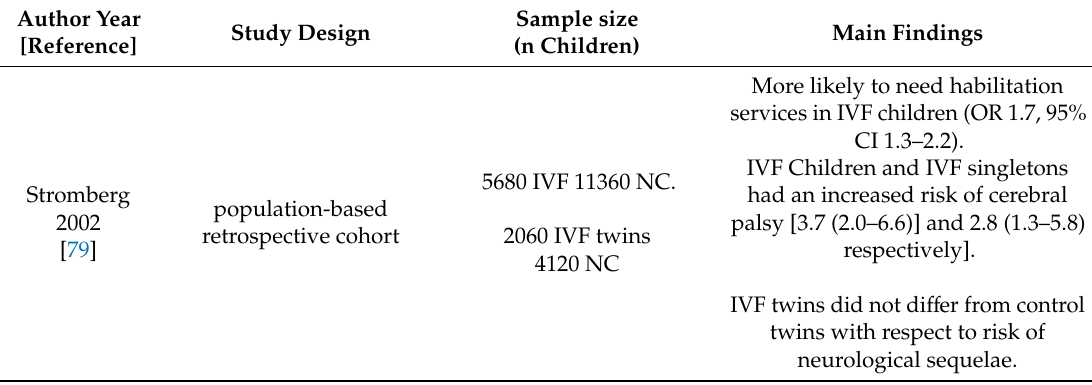
Table 2. Human Studies related to neurological disorders in ART-conceived o ff